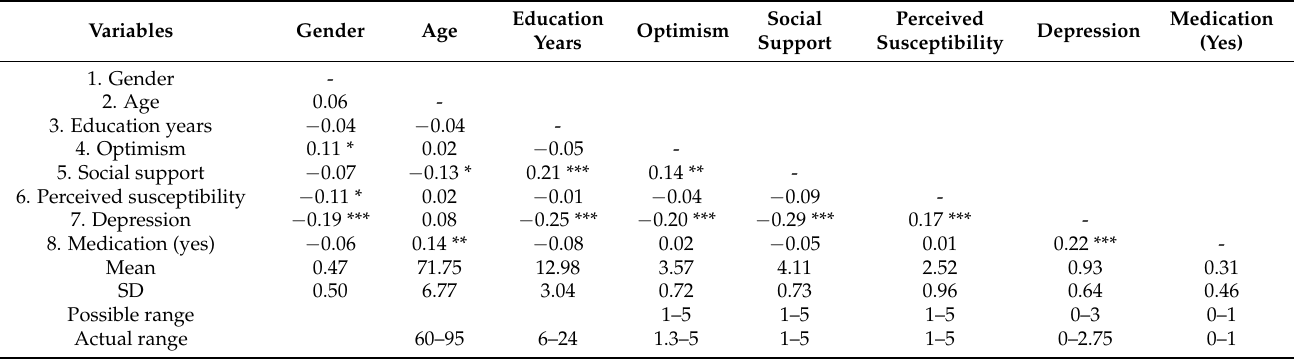
Table 2. Means, Standard deviations, Ranges, and Pearson Correlations for the Study Variables ( n = 383).